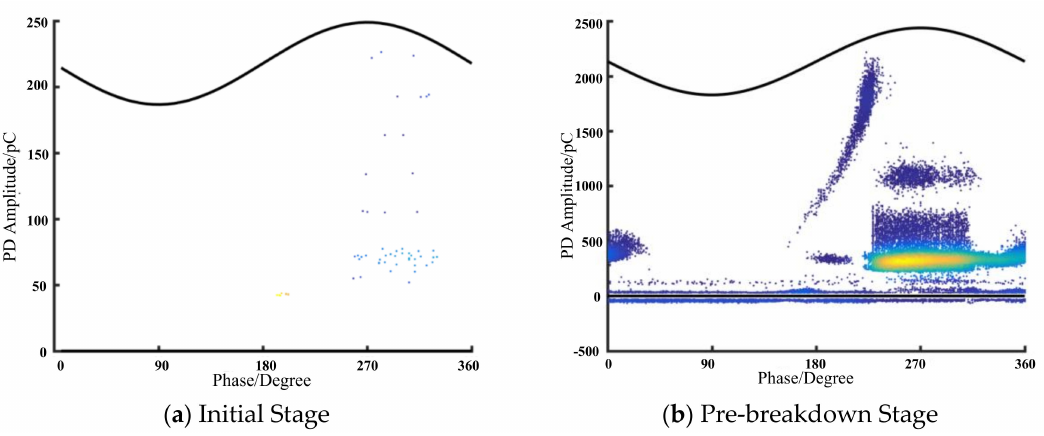
Figure 12. PRPD patterns under AC/DC proportion of